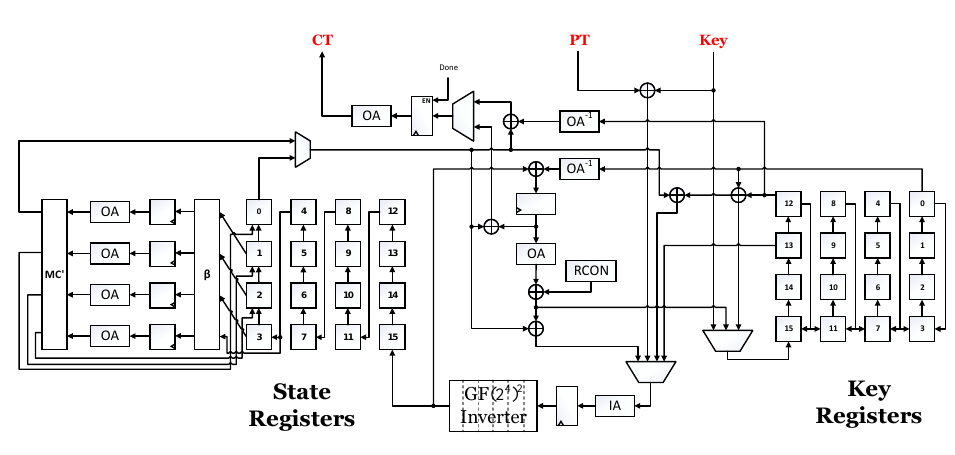
Figure 6: Our design of the serialized AES